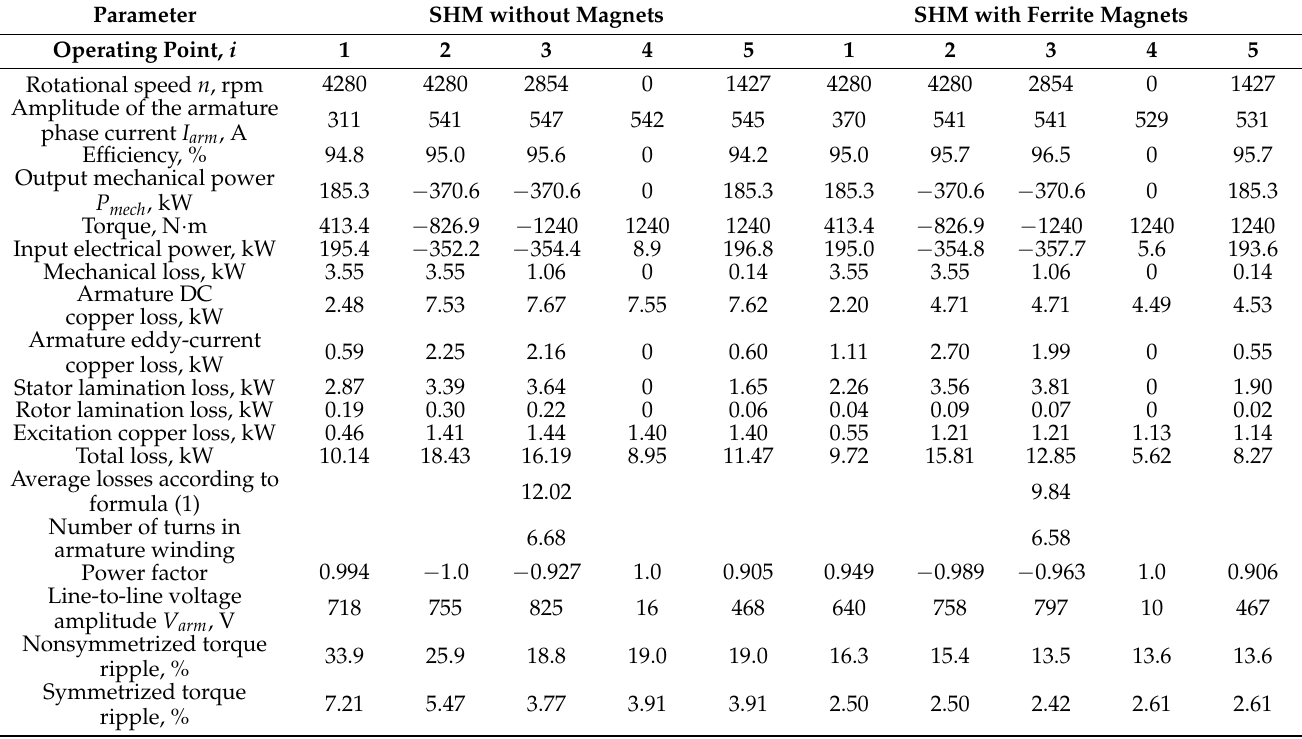
Table 6. Comparison of SHM with ferrite magnets and SHM without